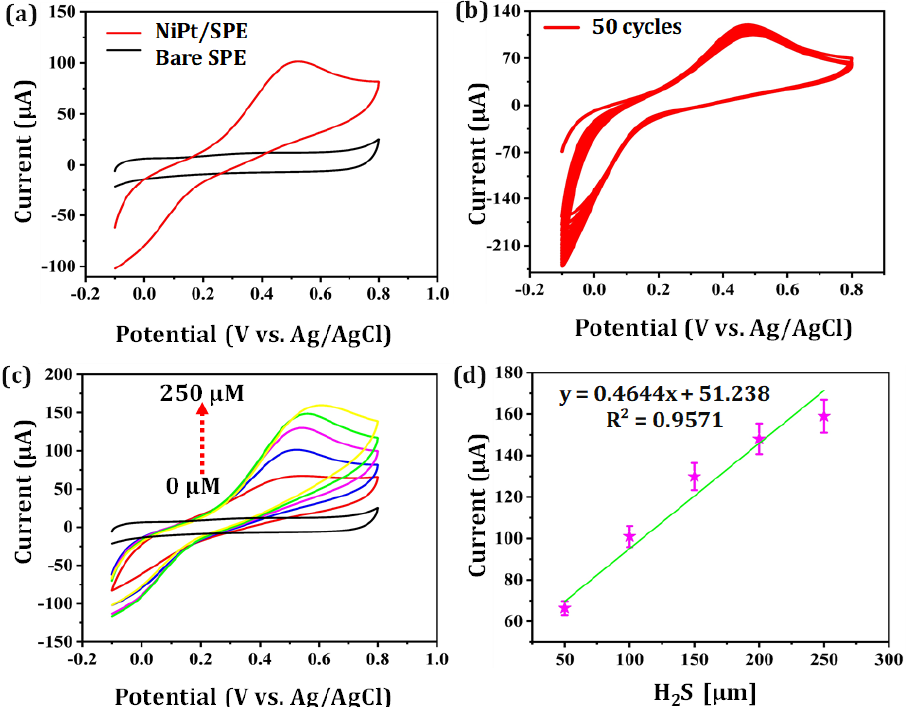
Figure 3. ( a ) CV curves of bare SPE and PtNi/SPE for 100 µ M sulfide in 0.05 M PB (pH 7.0) at a scan rate of 0.05 V s − 1 , ( b ) 50 consecutive CV cycles of PtNi/SPE in 0.05 M PB (pH 7.0) containing 100 µ M of sulfide at a scan rate of 0.05 V s − 1 , ( c ) CV curves of different concentrations of sulfide (0–250 µ M) at PtNi/SPE in 0.05 M PB (pH 7.0), ( d ) calibration plot of I pa vs. concentration ( µ M) of sulfide.